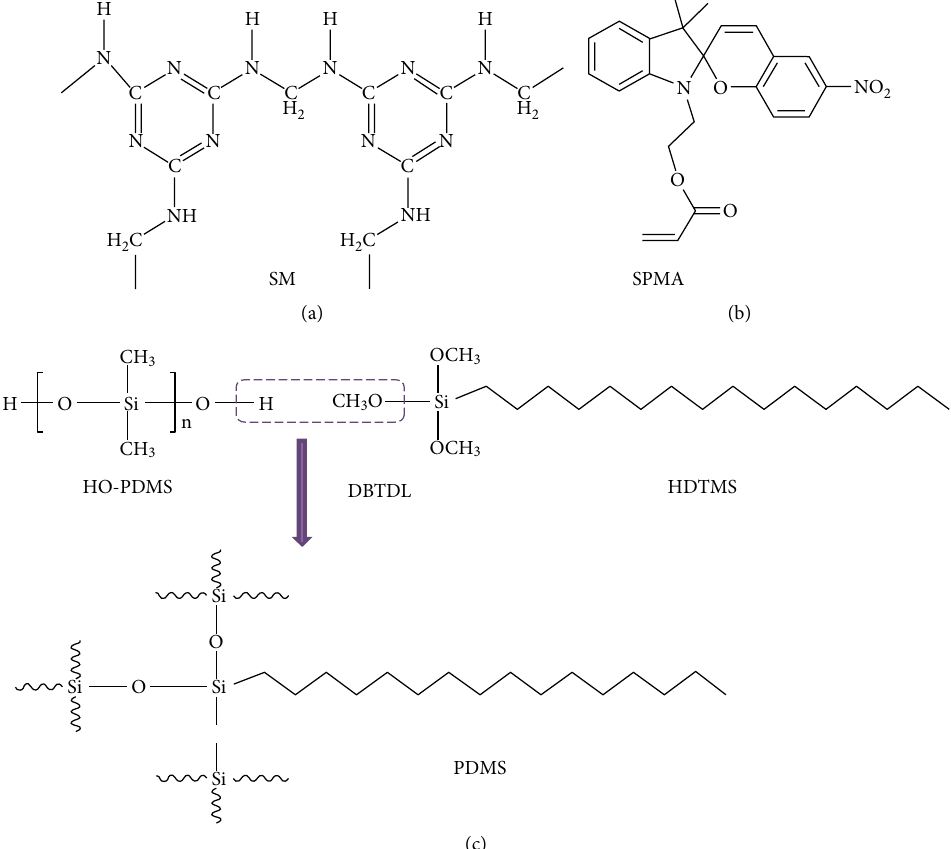
Figure 1: (a) Chemical structure of pristine melamine sponge, (b) chemical structure of SPMA, (c) schematic rout of PDMS